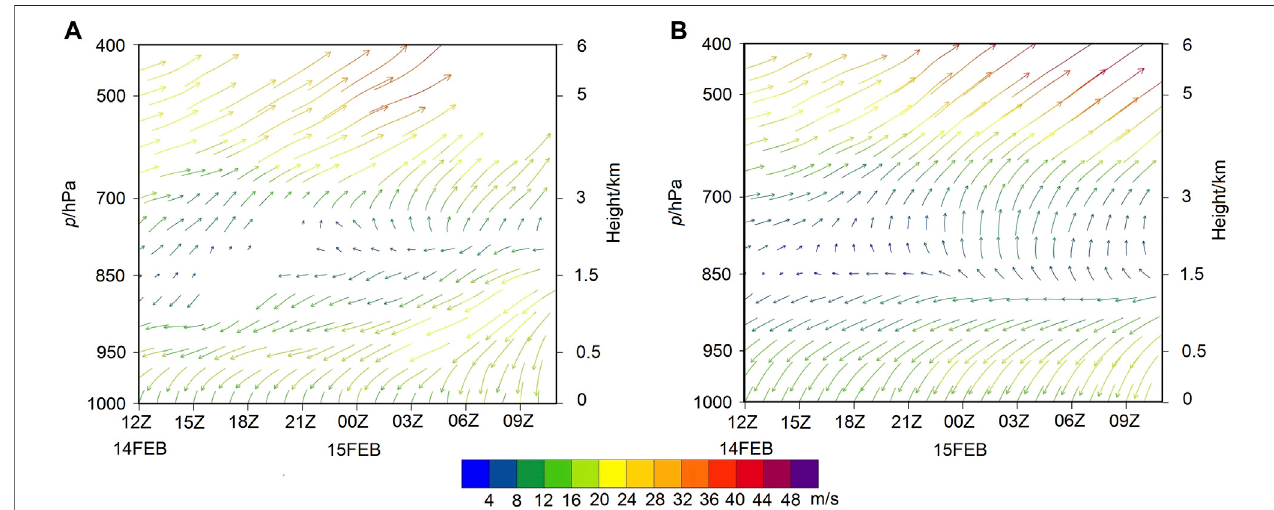
FIGURE 6 | Radar wind fi eld (A) and simulated wind fi eld (B) in Shenyang during the snowfall period from 0:00 on Day 1 to 0:00 on Day 2.